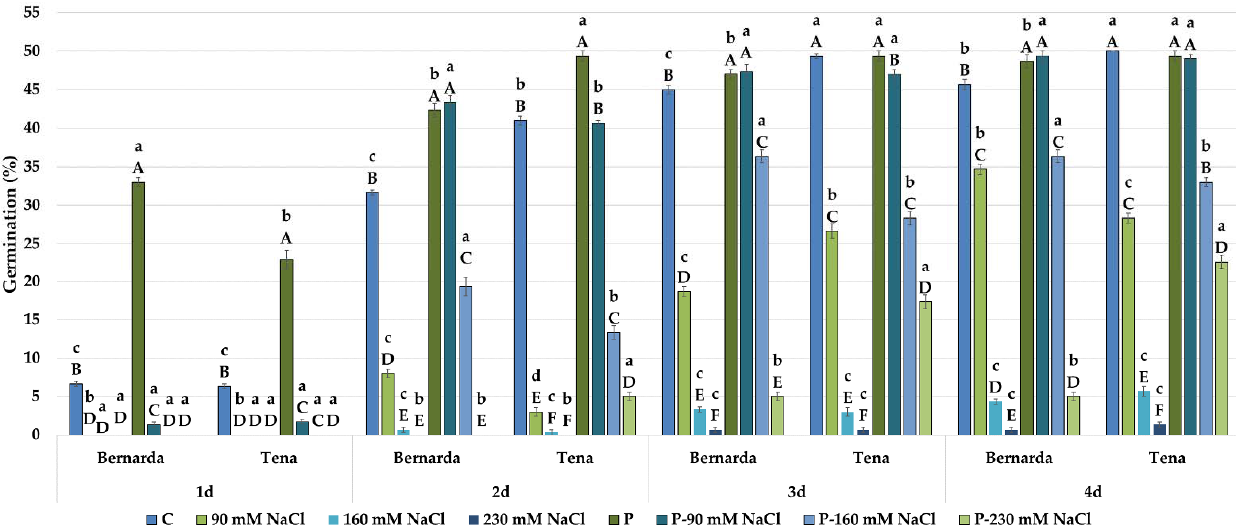
Figure 4. Germination percentages of two wheat genotypes during 4 days under control (C), salt treatments (90, 160 and 230 mM NaCl), high voltage electrical discharge (HVED) pretreatment (P) and combined (P-90 mM NaCl, P- 160 mM NaCl and P-230 mM NaCl) treatments. Values are means of three repetitions (100 seeds/repetition) ± S.D. The different capital letters indicate significances among means of different treatments within the same genotype, while lowercase letters indicate significances among means between genotypes under the same treatment at p < 0.05 using LSD post hoc-test.